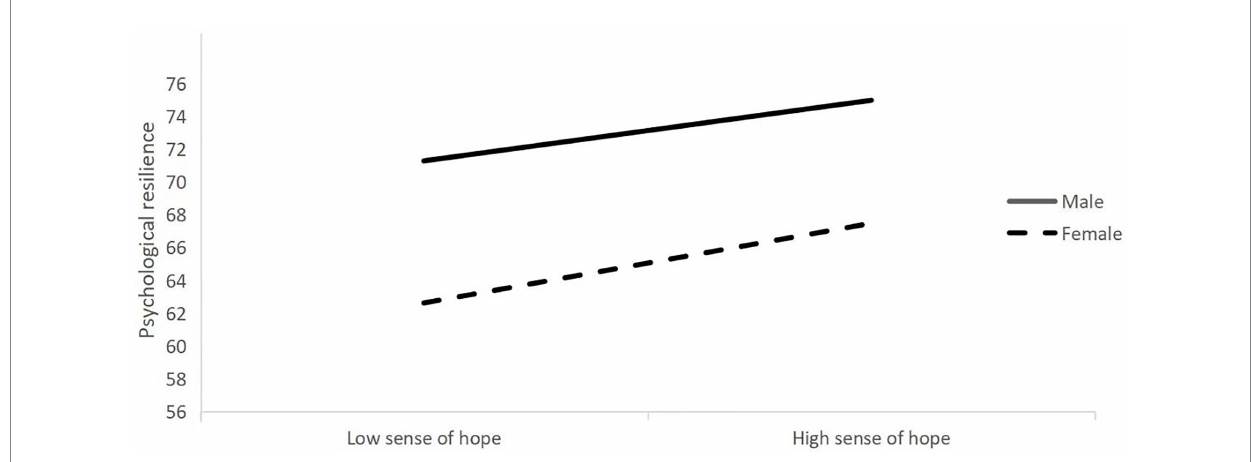
FIGURE 2 The moderating effect of the gender on the relationship between sense of hope and psychological